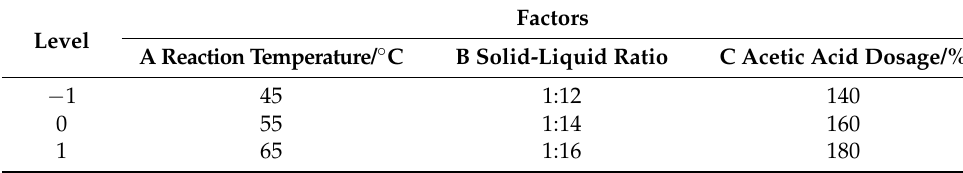
Table 1. Response surface test factor